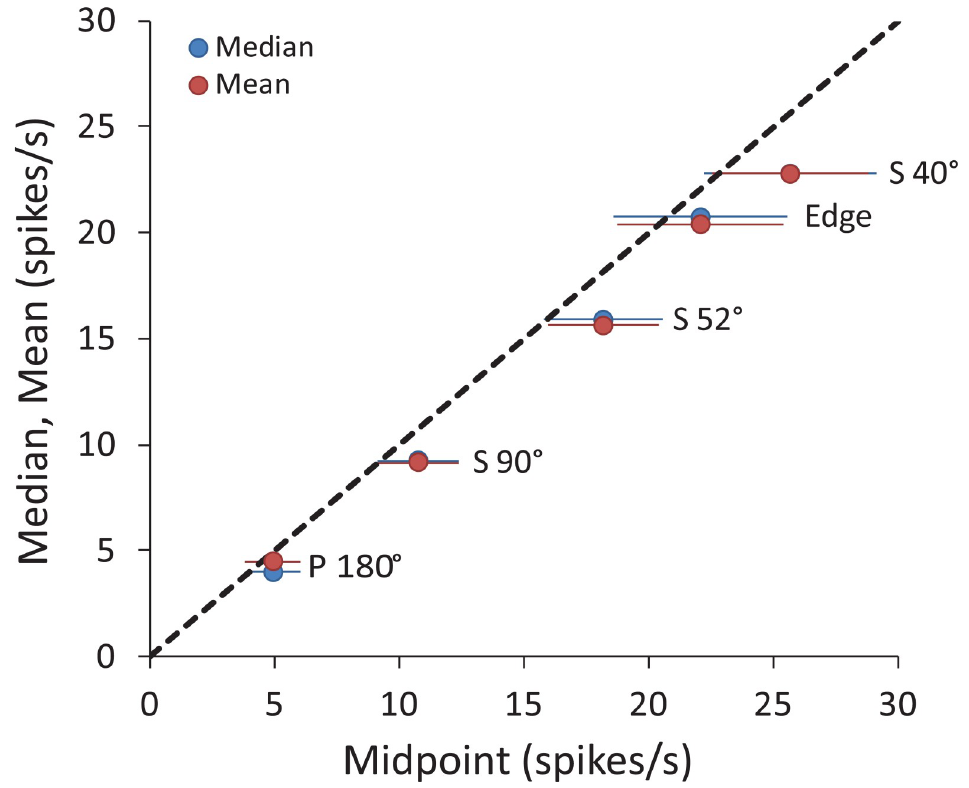
Fig 6. Neuron responses at corner-fold or edge midpoints are equivalent to the mean and median of neuron responses along the corner-folds or Edge. The figure shows the scatter plot of the mean (red dot) and median (blue dot) neuron responses along the folds or Edge versus the neuron responses at fold or Edge midpoints. The dotted line indicates equivalence between the two. Horizontal error bars represent the SEM (the N are as in Fig 5 ).